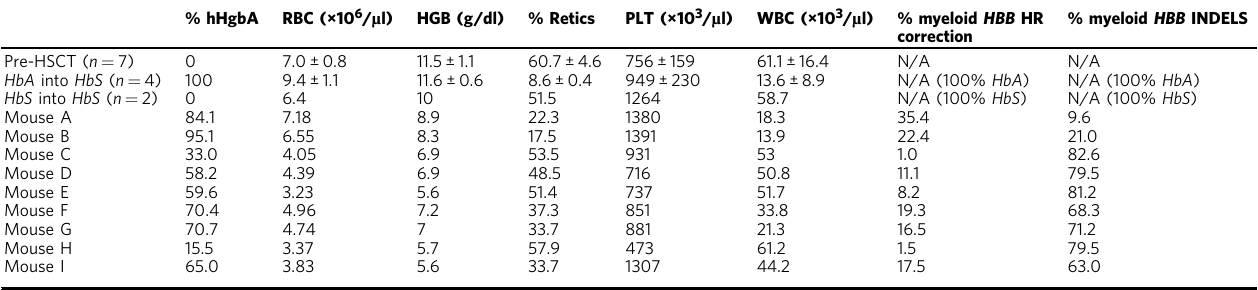
Table 1 Hematological parameters in Townes-SCD